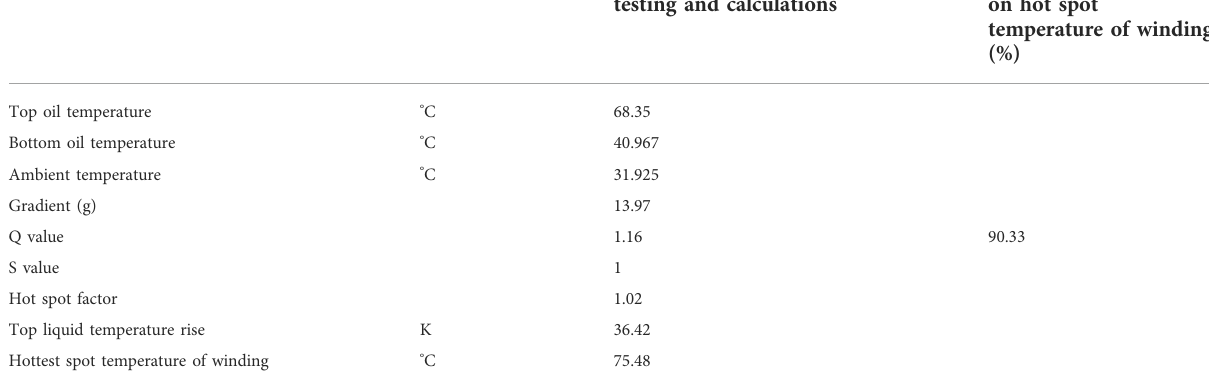
Health index based testing and calculations on hot